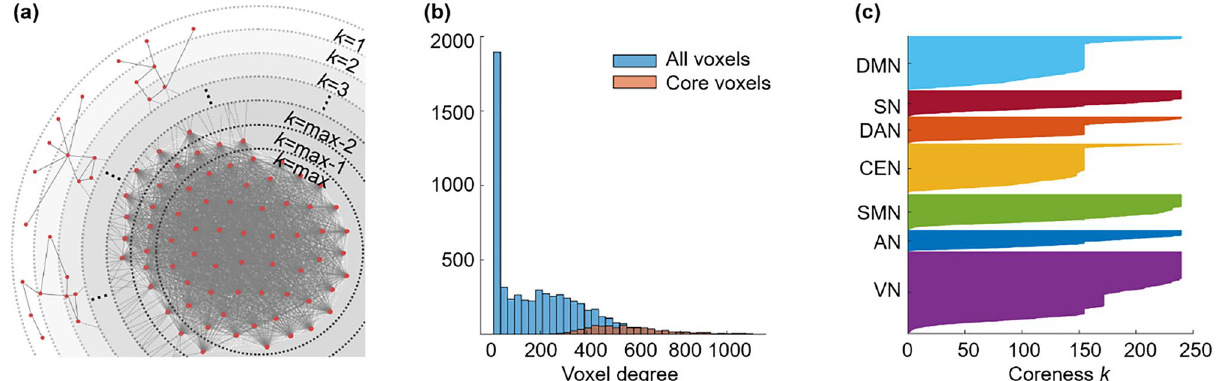
Figure 3. Conceptual illustration of k -core percolation and plots describing k -cores and the k max -core derived by k -core percolation. ( a ) k -core percolation renormalizes the brain network by peeling the layers with k -steps from k = 1 to k = k max for the brain network. Intervoxel correlations were thresholded to yield an adjacency matrix after checking the scale freeness of the degree distribution of voxels and put into hyperbolic disc embedding and k -core percolation. The voxels with a degree equal to coreness k are eliminated, and recalculation of the voxels’ degree proceeds to the next step and continues until the remaining voxels forming the largest component at that step are disintegrated into many pieces at once. The voxels at this step k = max are called k max -core voxels. ( b ) The k max -core voxels included not only the voxels with the largest degree on the initial adjacency matrix but also the voxels with smaller degrees. This histogram shows the degree distribution of voxels from one subject (#100,206). The blue bins represent all the voxels, and the red bins represent k max -core voxels. k max was 240, and the degrees of k max -core voxels ranged from 260 to 1088. The k -core percolation finds k max -core voxels that have dense connectivity among themselves as well as hierarchically at the apex within their belonging independent components (ICs) and even the voxels with lower down to one-fourth of voxel with the highest degree. ( c ) A flag plot shows the changing k -cores of a subject that vary with the coreness k value during k -core percolation. Each voxel that belongs to a specific IC is shown on the y-axis, and the voxels comprising each k -core are colored. This subject has a k max core with a 240 k-value and shows the first abrupt decrease during k -core percolation in DMN, DAN, CEN, and VN ( k ≈ 156) and the second abrupt decrease in VN ( k ≈